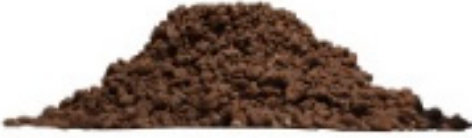
Figure 7. The accumulation body.